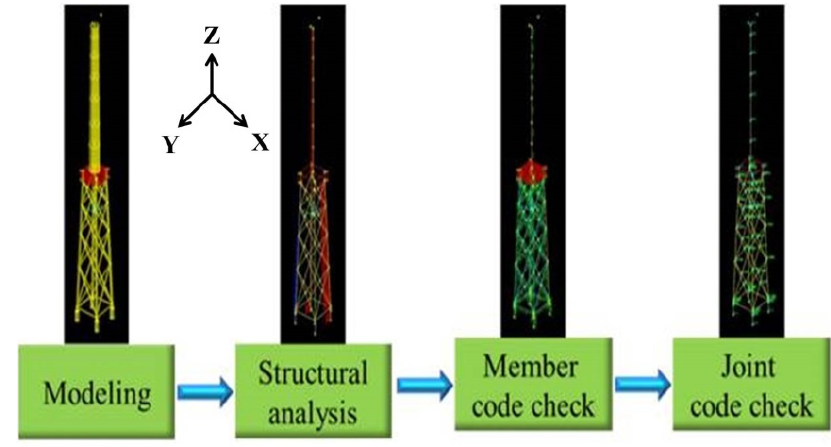
Figure 17. Model Construction and Verification of OC4 Jacket Substructure Model.